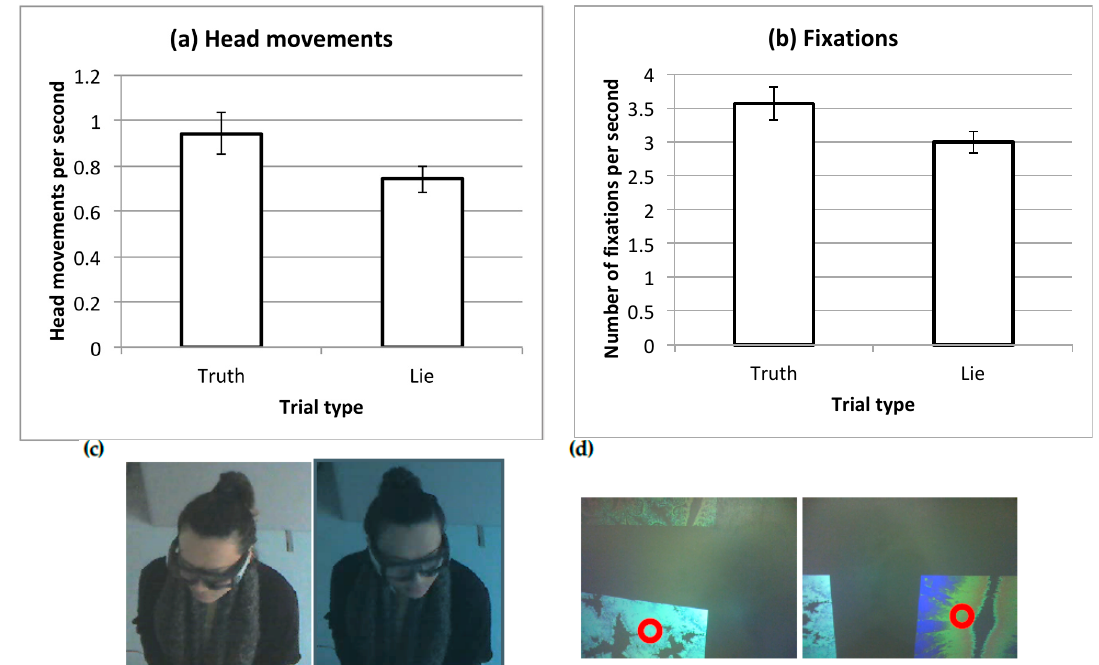
Figure 3. Frequency of orienting movements in the two types of trial. Bars show the mean across participants with standard error bars, for ( a ) head movements coded from video and ( b ) fixations recorded by the mobile eyetracker. Examples of the two behaviors are also shown: in ( c ), video frames showing a movement from the observer’s right to their left; in ( d ), fixations shown by a circular cursor in the participant’s scene camera.